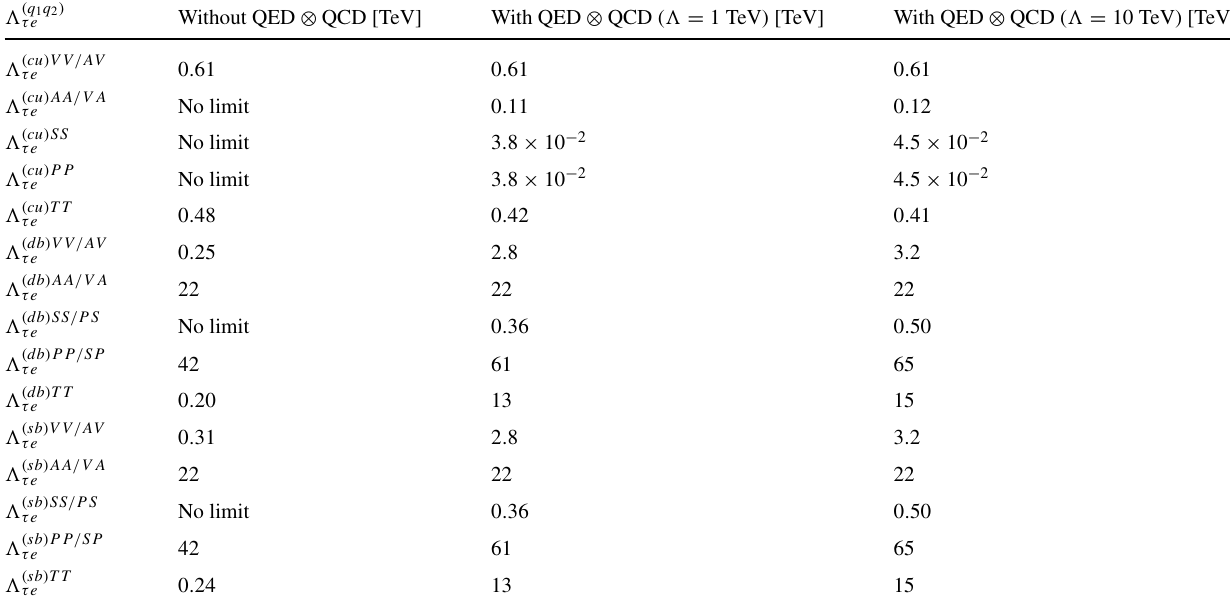
( q 1 q 2 ) AB (cid:2) 1 (cid:2) 2